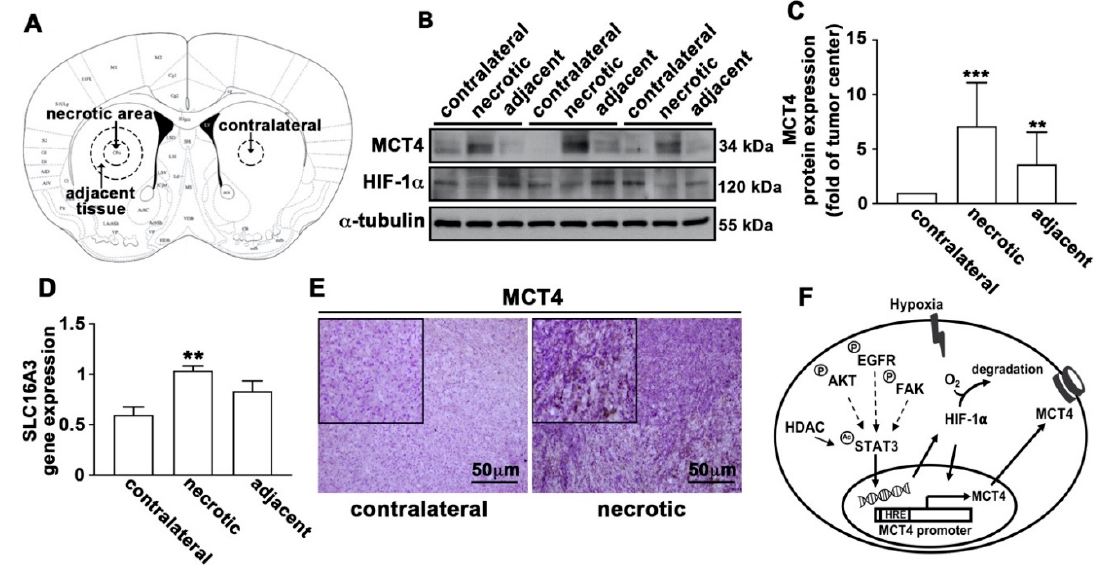
Figure 9. MCT4 expression is up-regulated in the GBM mouse model. ALTS1C1 (mouse GBM) cells were intracranially injected into the brain of C57BL/6 mice ( n = 9). After 14 days, all the animals